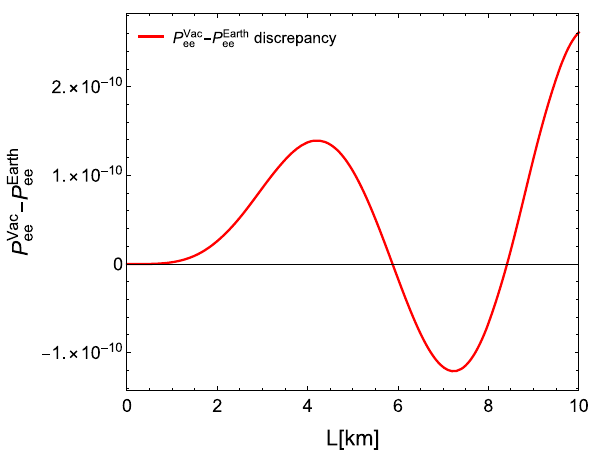
Fig. 1 Illustration of the matter effect of the Earth in the interval of 0–10 km. The plot is the discrepancy of vacuum P Vac ee and the Earth’s P Earth ee . The neutrino is 6 MeV monoenergetic, and ρ( x ) = 2 . 65 g / cm 3 for standard